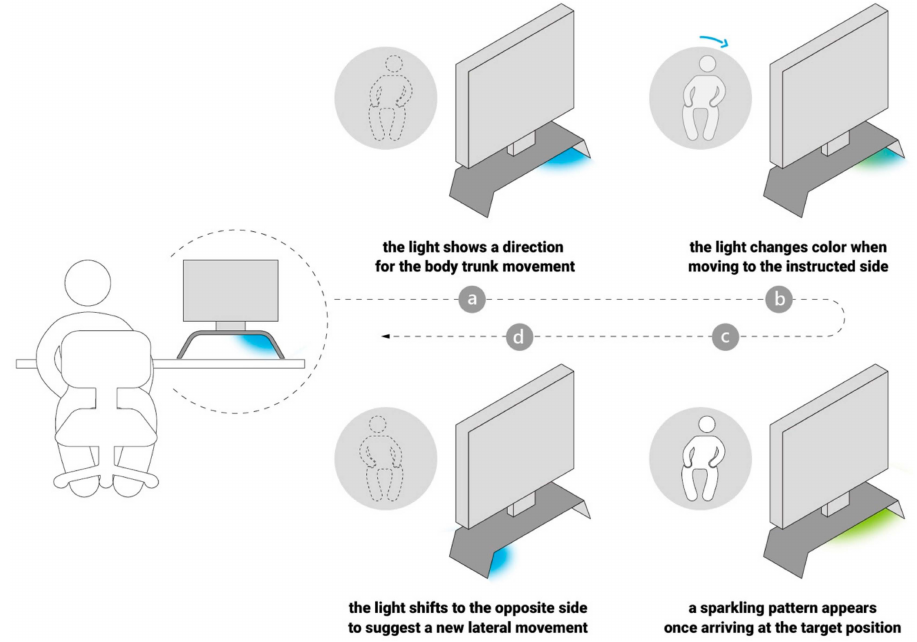
Figure 7. The working mechanism of LightSit to assist with lower back stretching fitness. ( a ) The light shows a direction for the body trunk movement. ( b ) The light changes color when the user moves to the instructed side. ( c ) a sparkling pattern appears once the user arrives at the target position. ( d ) The light shifts to the opposite side to suggest a new lateral movement.